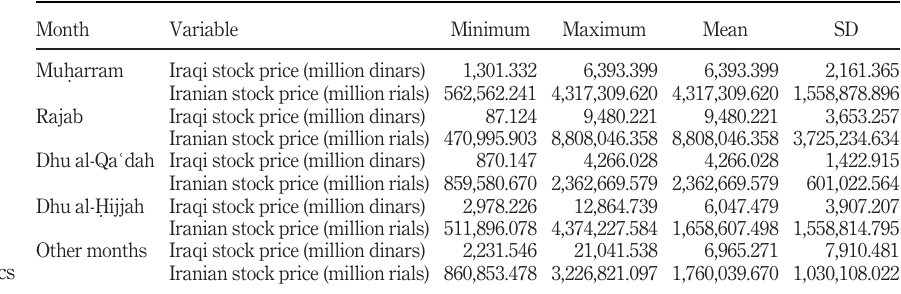
Table I. Descriptive